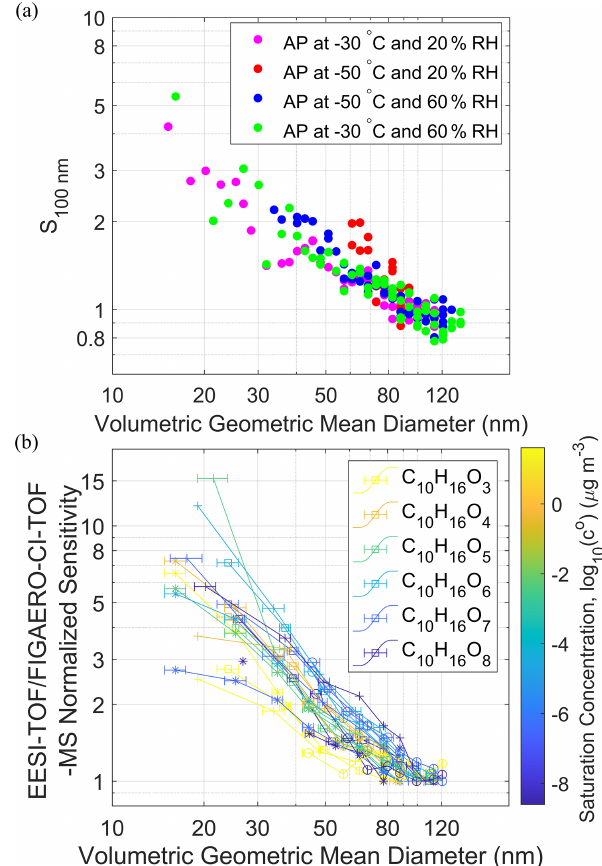
Figure 3. (a) Normalized sensitivity of the EESI-TOF calculated from the sum of high-resolution fitted organic ion signals and the to- tal particle mass concentrations as a function of the volumetric geo- metric mean diameter over the course of new particle formation and growth of α -pinene (AP) ozonolysis SOA. See Figs. S8, S9 and S10 for more information. (b) Normalized sensitivity of the EESI- TOF intensity divided by the FIGAERO-CI-TOF-MS intensity for C 10 H 16 O 3–8 molecules in the particle phase as a function of the volumetric geometric mean diameter. Different marker types (cid:3) , , (cid:13) , + indicate different SOA formation conditions, i.e., at − 30 ◦ C and 20% RH, − 50 ◦ C and 20% RH, − 50 ◦ C and 60% RH, − 30 ◦ C and 60% RH, respectively. The saturation concentration was esti- mated as log 10 (c 0 ) = (n 0 c − n c )b c − n o b o − 2 · b co (n c n o )/(n c + n o ) from the number of carbon and oxygen ( n c , n o ) and coefficients ( b c , b o , b co ) provided in Donahue et al.